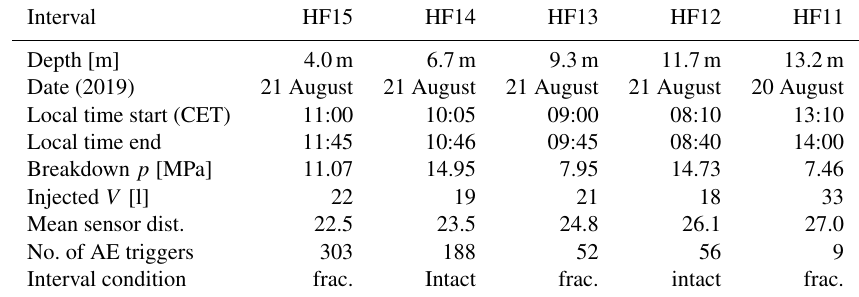
Table 2. Overview of stimulation details for the 10 stimulated intervals of the injection borehole. The total injected volume and number of AE events are given for the whole stimulation sequence as shown in Fig. 4. The stimulation intervals were chosen to contain as few pre-existing structures as possible based on cores and acoustic logs. The interval condition was reassessed based on the stimulation results as either intact where hydrofracs were created or pre-fractured, meaning that hydroshearing occurred. Interval HF10 HF4 HF3 HF5 HF6 HF9 HF8 HF2 HF7 HF1 Depth [m] 22.4 Local time start (CET) Breakdown p [MPa] Injected V [l] 457 466 200 Mean sensor dist. No. of AE events 4537 Period [s] of hydr. pumping 400 400 30–240 Interval condition intact intact intact frac. intact frac. frac. frac. frac. frac. Table 3. Minifrac measurement interval details for the vertical validation borehole. See Table 2 for explanation. Interval HF15 HF14 HF13 HF12 HF11 Depth [m] 4.0m Local time start (CET)